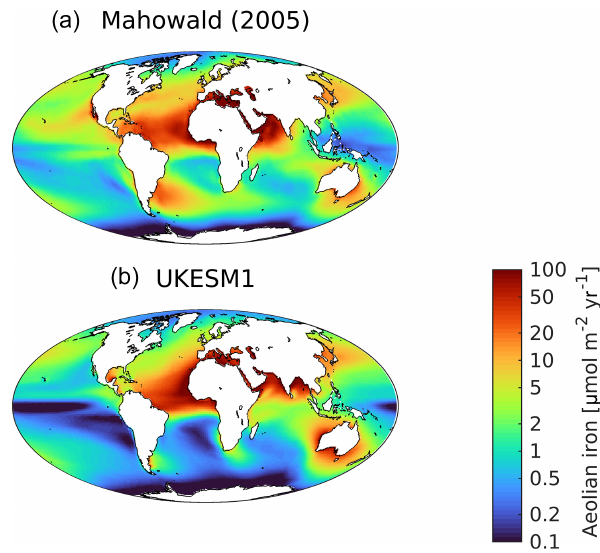
Figure 12. Observational ( a ; Mahowald (2005)) and simulated en- semble mean (b) aeolian deposition of iron. Due to its large dy- namic range, deposition flux is shown on a logarithmic scale. De- position is given in µmolFem − 2 yr − 1